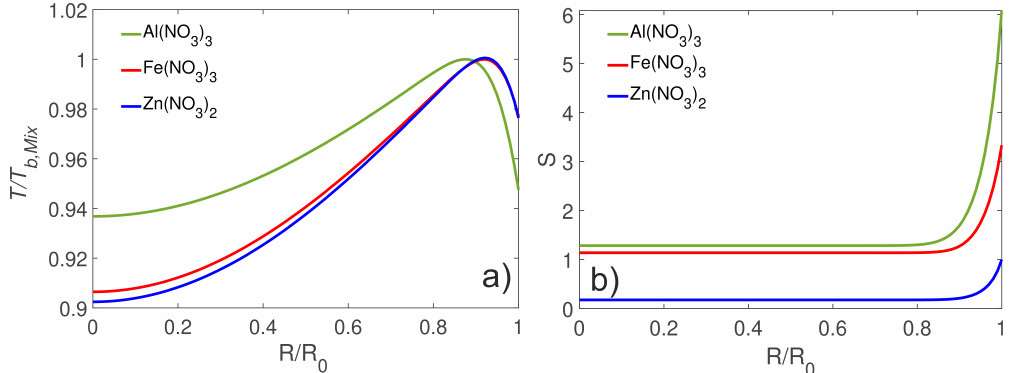
Figure 7. ( a ) Normalized temperature field at the onset of superheating. Superheating occurs below the droplet surface; ( b ) saturation ratios at the onset of superheating. Supersaturation is highest at the droplet